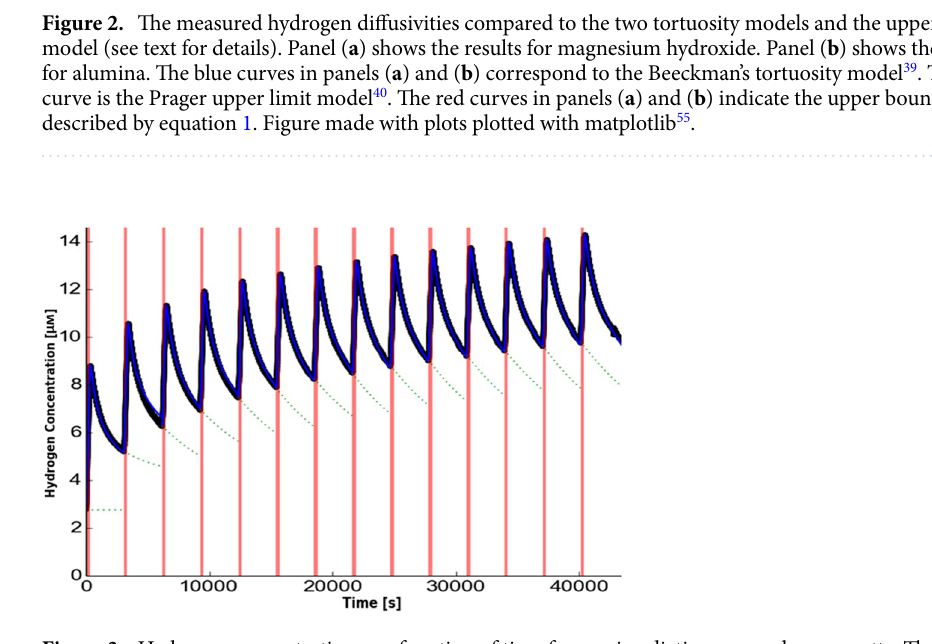
Figure 3. Hydrogen concentration as a function of time for one irradiation run and one cuvette. The black trace shows the measured data, the fit to a 1-dimensional diffusion model 33,49 is shown in blue, the green dotted line shows the extrapolation of the background signal of hydrogen concentration from previous irradiations within the run. As the distance to the irradiated region and the start time are independently determined, there are two free parameters in the model: the diffusion coefficient, which determines the overall model shape, and the model parameter related to the radiolytic yield, which acts as an overall scaling factor. The results from these fits are reported in Table 1. Figure made with plot plotted with matplotlib 55